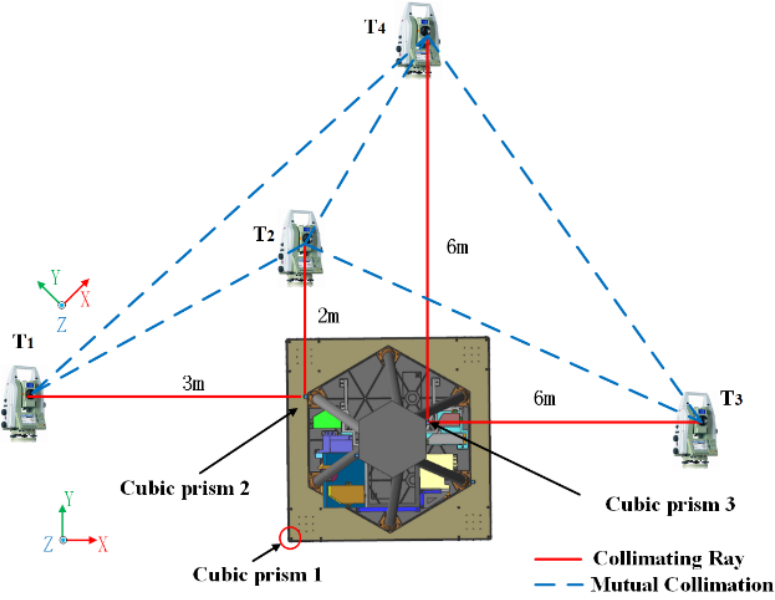
Figure 10. Diagram of theodolite angle intersection measurement.